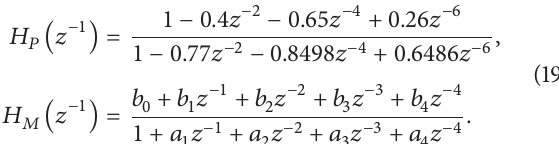
Table 1: Performance results of the first experiment.